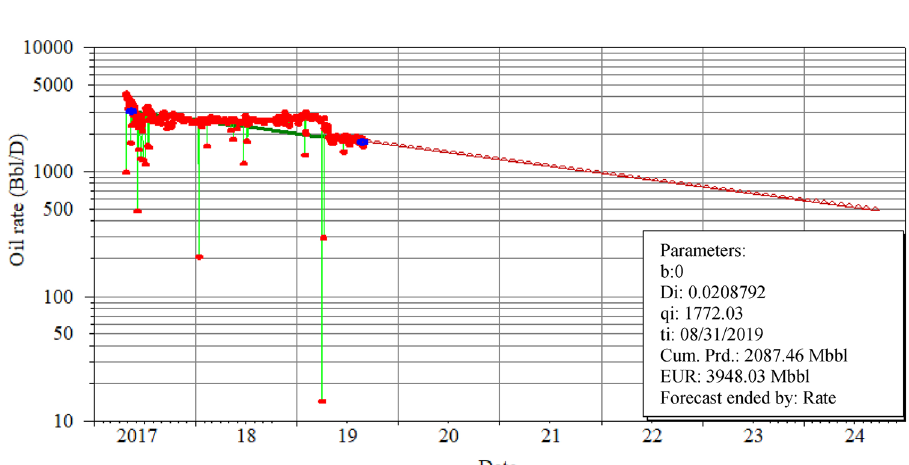
Fig. 11 Decline curve analysis (DCA) for candidate